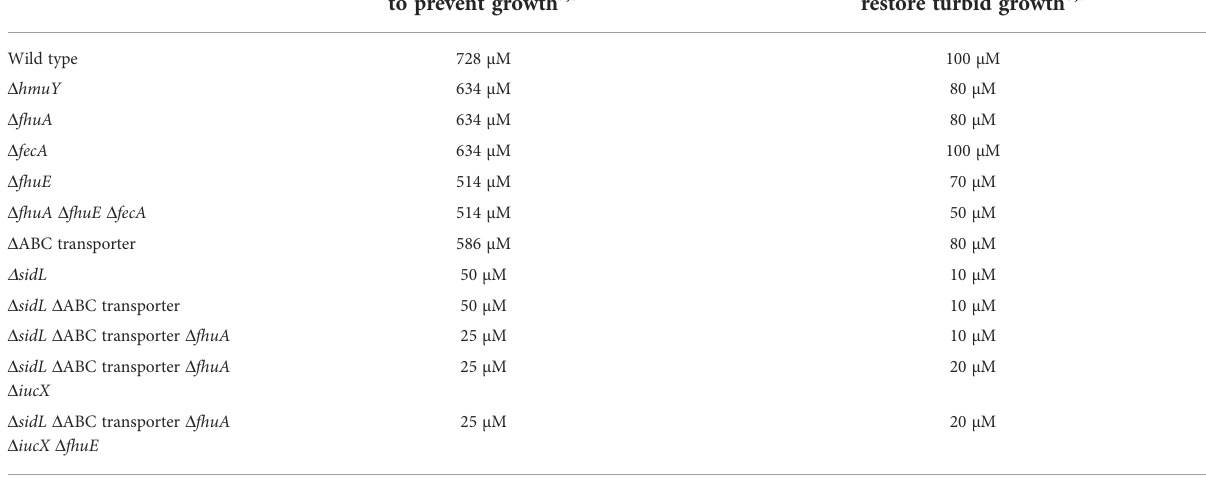
TABLE 3 F. columnare growth in TYES with iron chelator, with and without supplemental iron. Strain Concentration of chelator (deferiprone) required Concentration of added iron (FeCl 3 ) needed to to prevent growth a,b restore turbid growth b,c